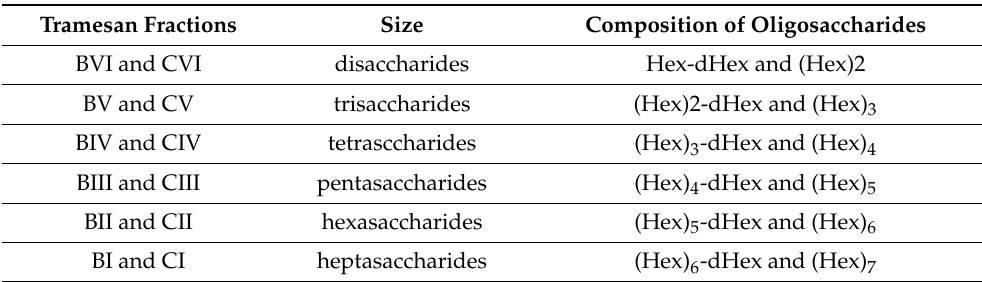
Figure 4. Electrospray ionization-mass spectrometry (ESI-MS) spectrum of sample B II obtained after hydrolysis of the polysaccharide purified from the T. Versicolor culture filtrate. The most abundant (M+Na) + oligosaccharides’ parent ions are indicated. Table 1. Size and composition of the oligosaccharides present in the Tramesan © fractions after acidic hydrolysis of the native